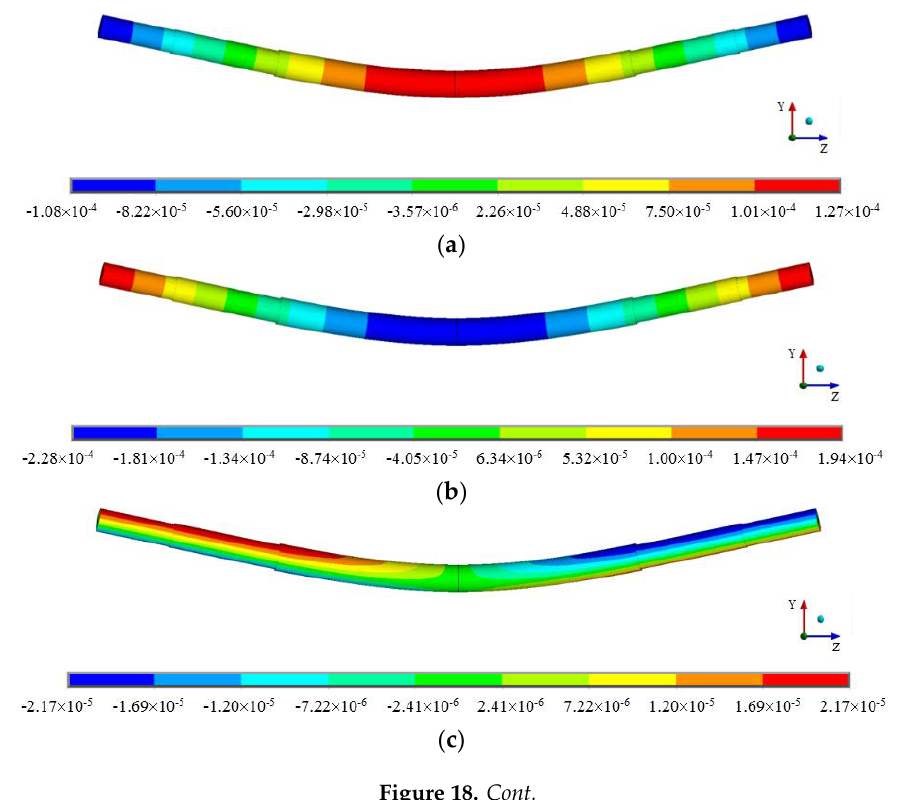
Figure 17. Comparisons of pressure fluctuation intensity coefficient under different flow conditions.